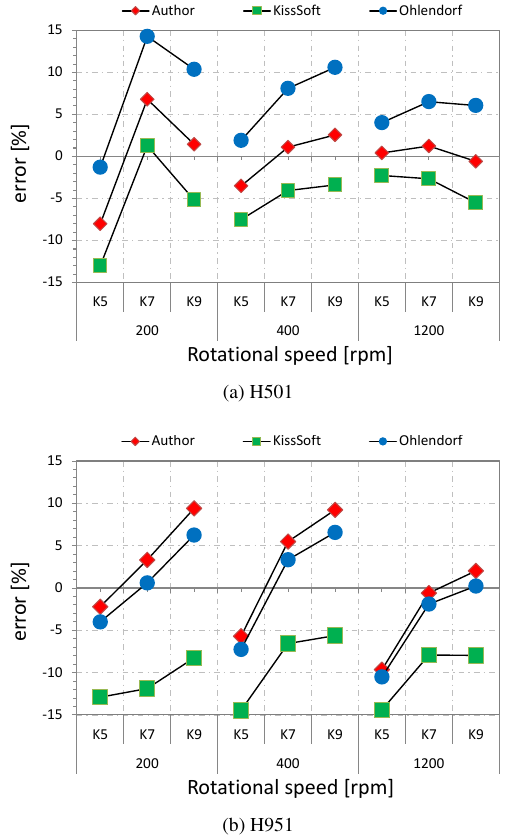
Figure 4. Correlation between the experimental power loss mea- sured and the predicted with Author, Ohlendorf or KissSoft gear loss